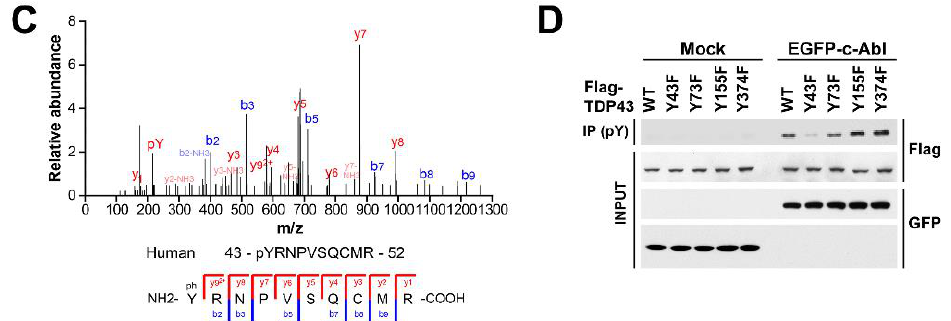
Figure 1. c-Abl phosphorylates TDP-43 at tyrosine 43. ( A ) in vitro kinase assay with recombinant Kinase active form of c-Abl (c-Abl KA) and TDP-43. ( B ) Non-radioactive kinase assay adding cold ATP. c-Abl–phosphorylated TDP-43 indicated by asterisk. ( C ) MS/MS spectrum of the phosphorylated peptide fragment of c-Abl–phosphorylated TDP-43. ( D ) Co-immunoprecipitation experiments in SH-SY5Y cells co-transfected with EGFP-c-Abl and phospho-deficient mutant forms of TDP-43.